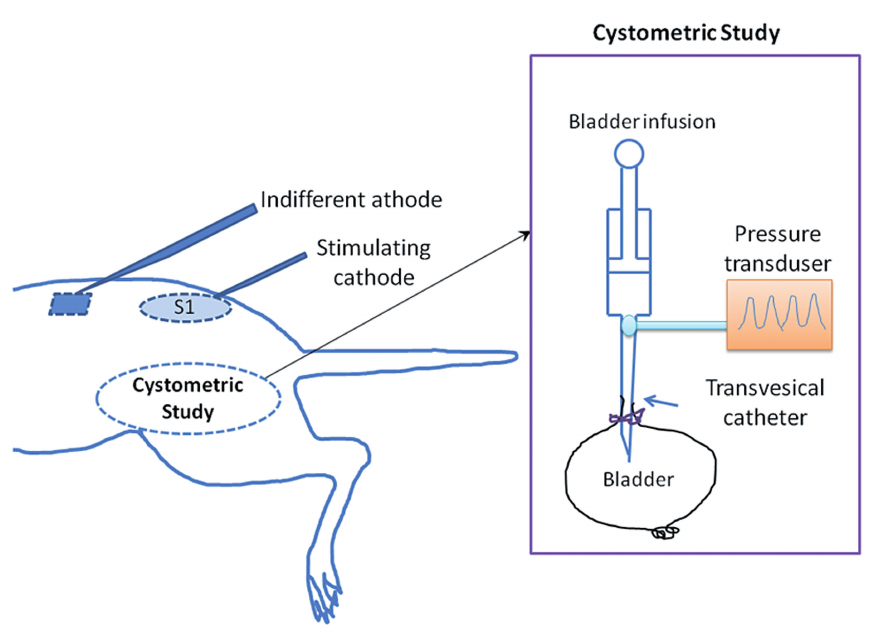
figure 1 - schematic diagram of the experimental set up on the rats for recording bladder activity with snM treatment. A pE tube was inserted into the bladder dome, which was in turn connected via a three-way stopcock to an infusion pump for filling with saline, and to a pressure transducer for monitoring bladder pressure. The cathode electrode was inserted into the s1 foramina, and the anode was placed under the skin of the